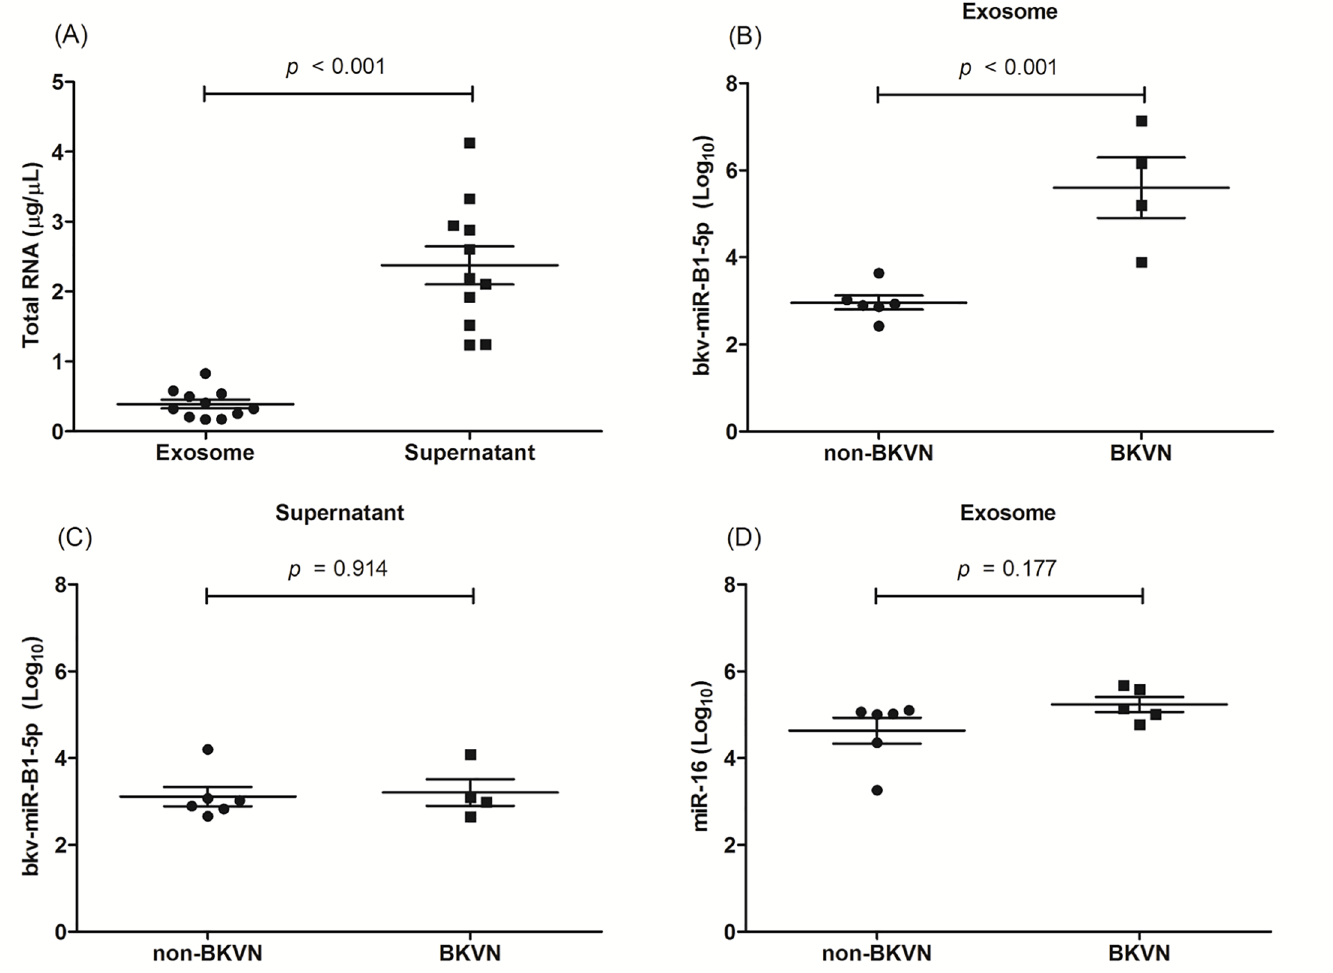
Fig 1. Comparison of the levels of viral microRNAs between urinary supernatant and exosomal fraction. (A) The levels of total RNA in urinary exosomal fraction and urinary supernatant. (B) and (C) The levels of bkv-miR-5p in patients without BKVN and those with BKVN. (B) indicatesthe levels of bkv-miR-5p in urinary exosomalfraction, and (C) indicatesthose in urinary supernatant. (D) The levels of miR-16 in urinary exosomalfraction of patients with BKVN and those without BKVN.